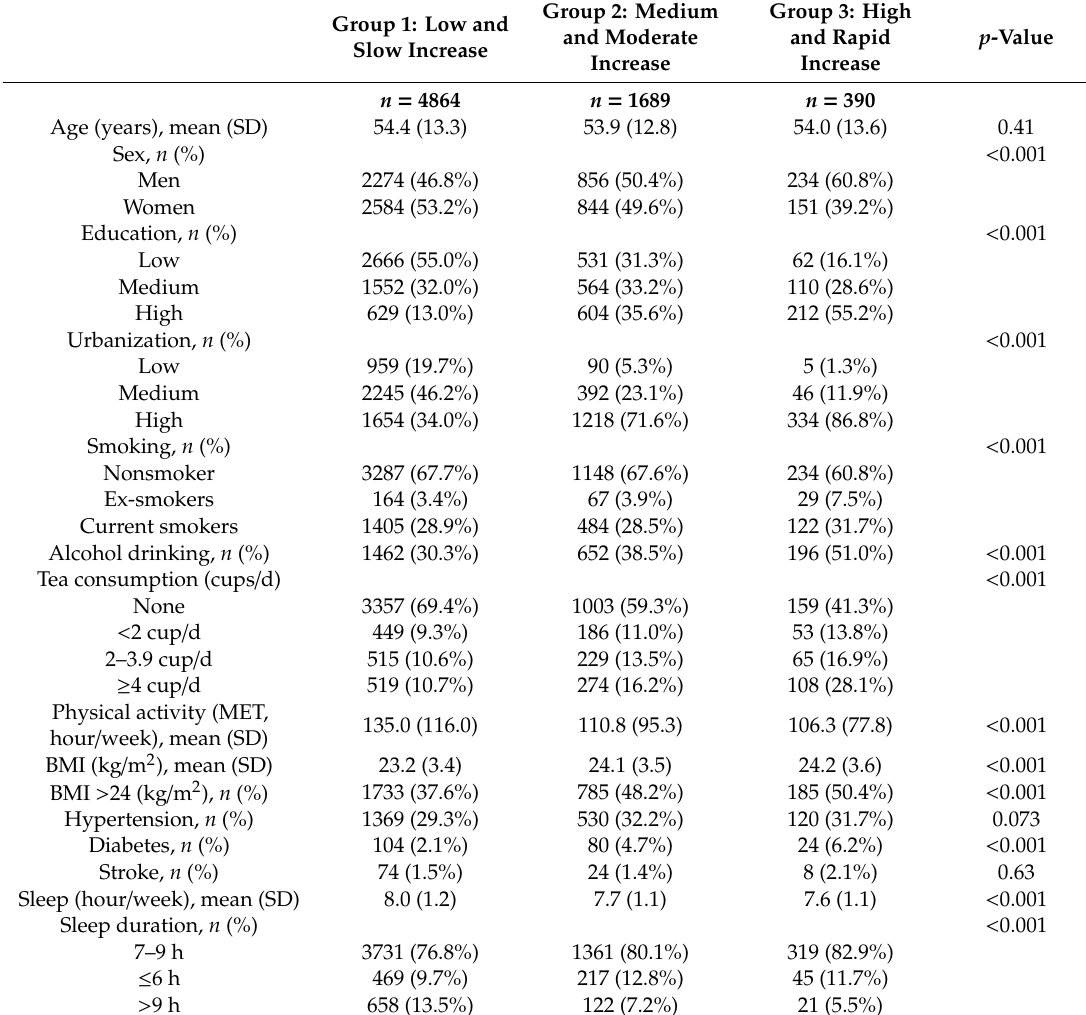
Table 2. Sample characteristics by trajectory of modern dietary pattern in 2009 ( n = 6943) *